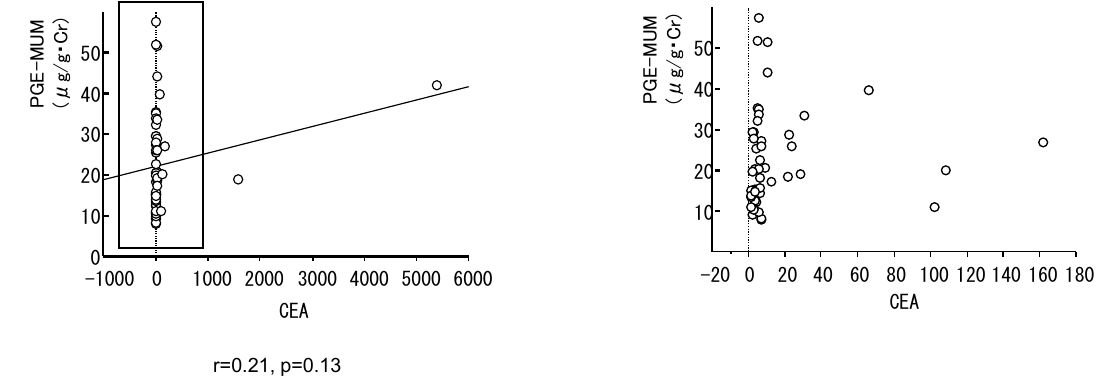
Figure 4. Association of PGE-MUM levels with carcinoma embryonic antigen (CEA). A scatter plot of PGE-MUM and CEA (left: whole data, right: magnification of the box in the left panel).